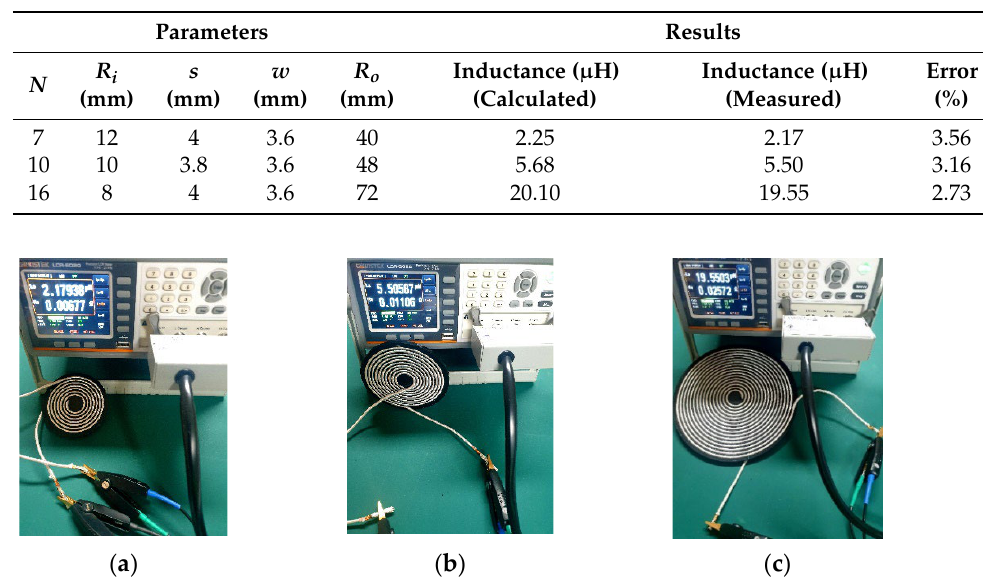
Table 1. Comparison of the calculation and measurement result.